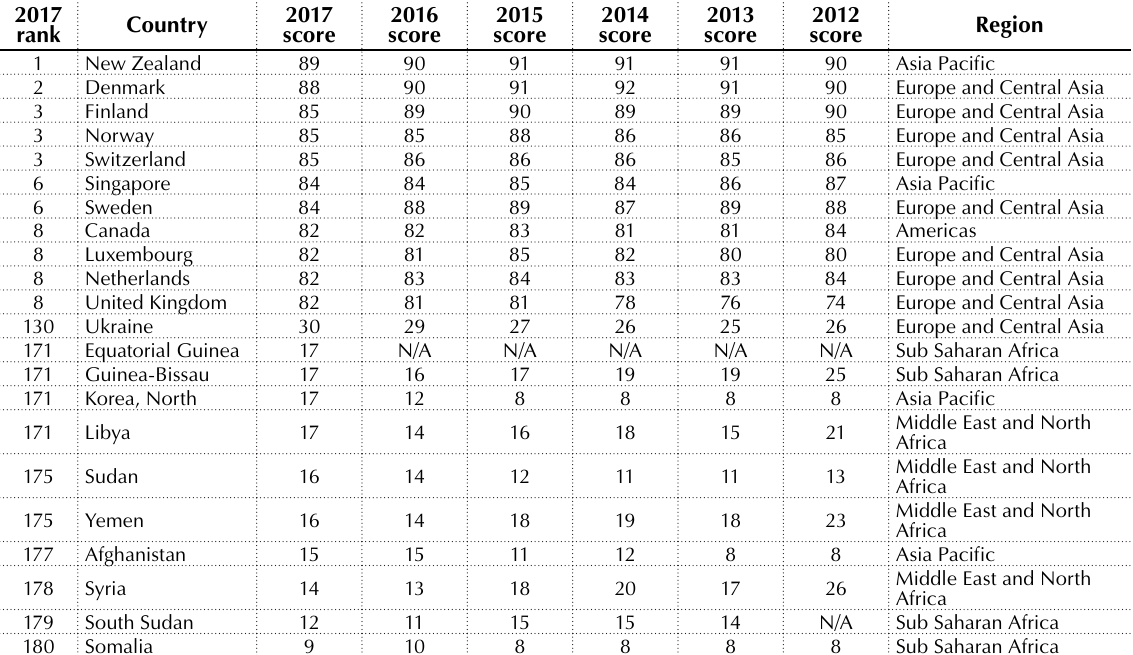
Table 3. Corruption Perceptions Index, 2017